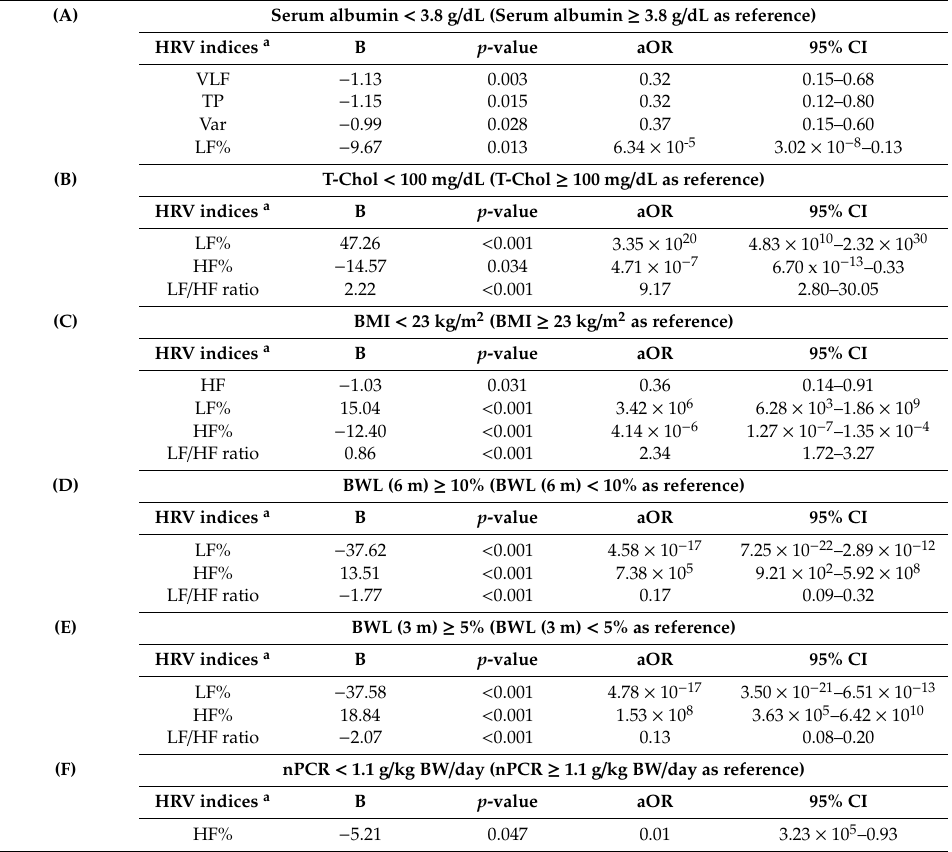
Table 3. Heart rate variability indices independently associated with worse nutritional